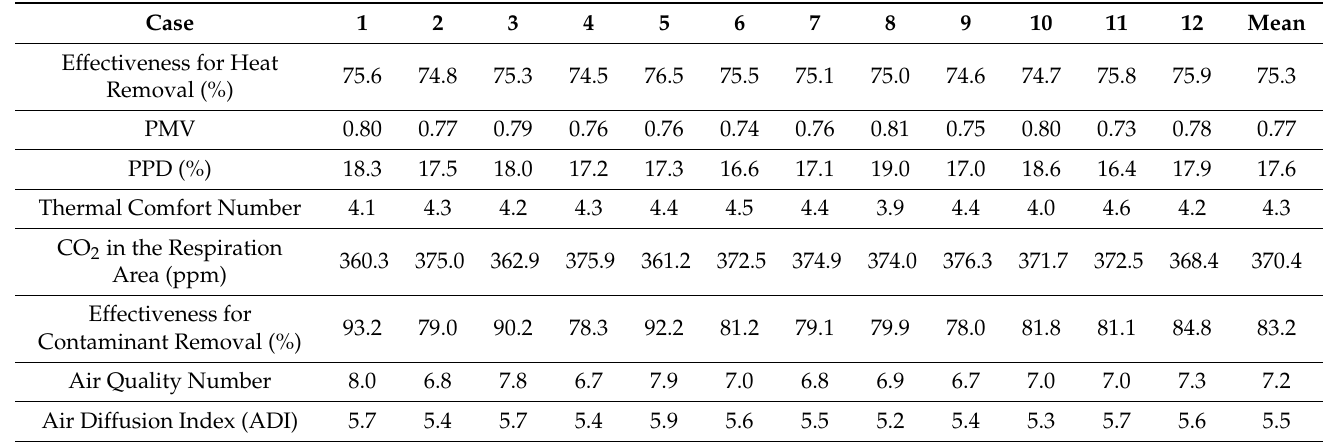
Table 10. ADI obtained for Case III (0.1556m 3 /s) at 16 h.